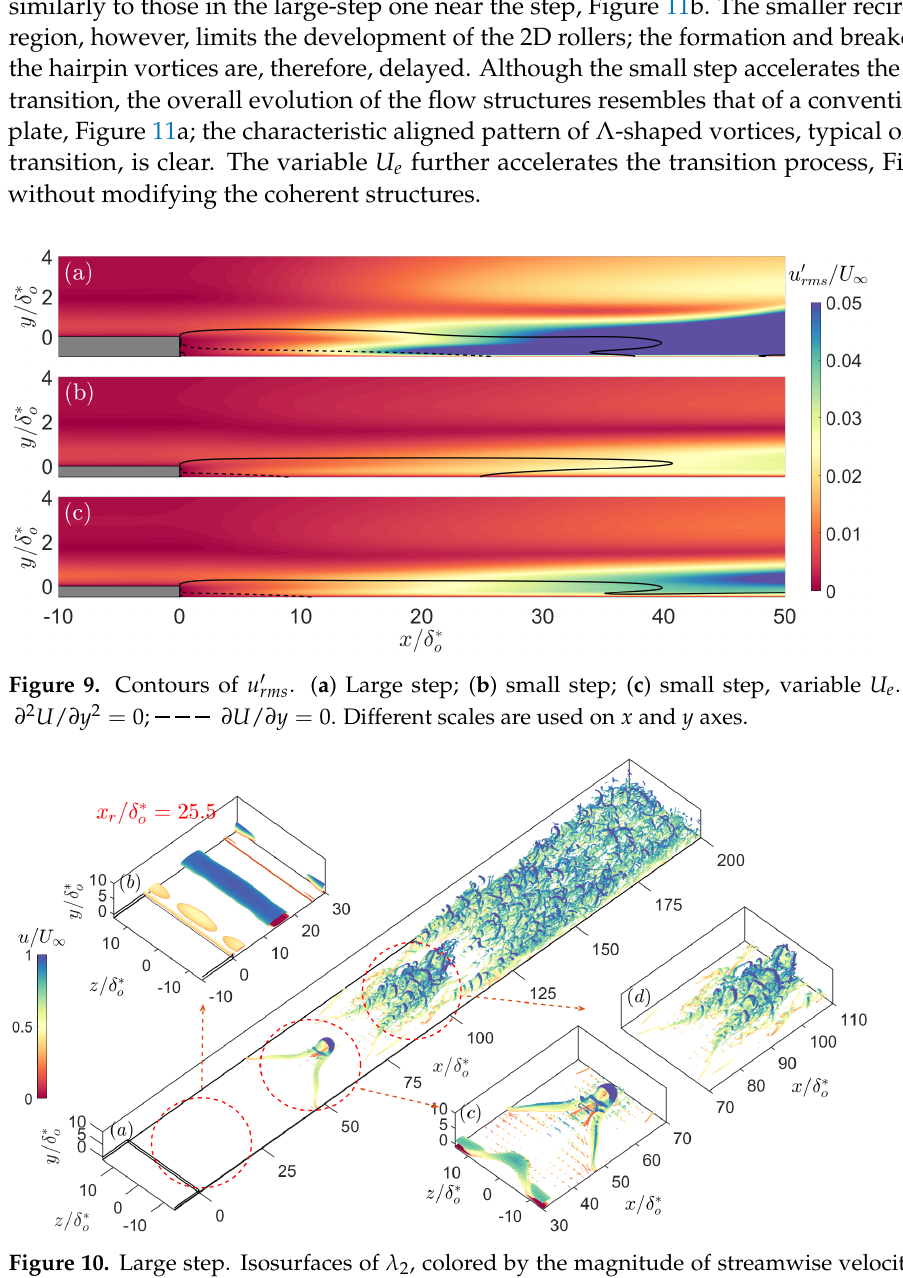
Figure 10. Large step. Isosurfaces of λ 2 , colored by the magnitude of streamwise velocity, u / U ∞ . ( a ) λ 2 = − 2.0 × 10 − 2 ; ( b ) λ 2 = − 2.5 × 10 − 4 ; ( c ) λ 2 = − 2.5 × 10 − 3 ; ( d ) λ 2 = − 2.5 × 10 − 2